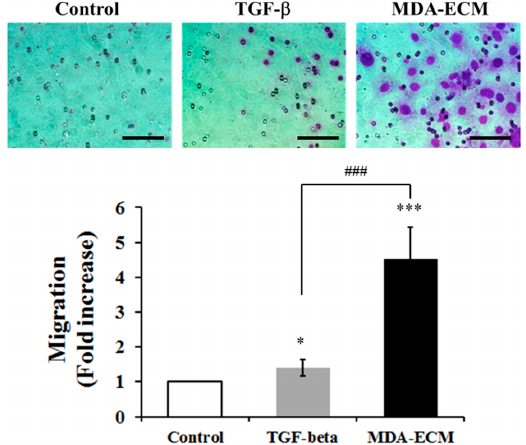
Figure 5 . Effect of MDA-ECM on the migratory capacity of MCF-7 cells. MCF-7 and MDA-MB-231 cells were cultured in standard conditions for 72 h, and decellularized ECMs were obtained,